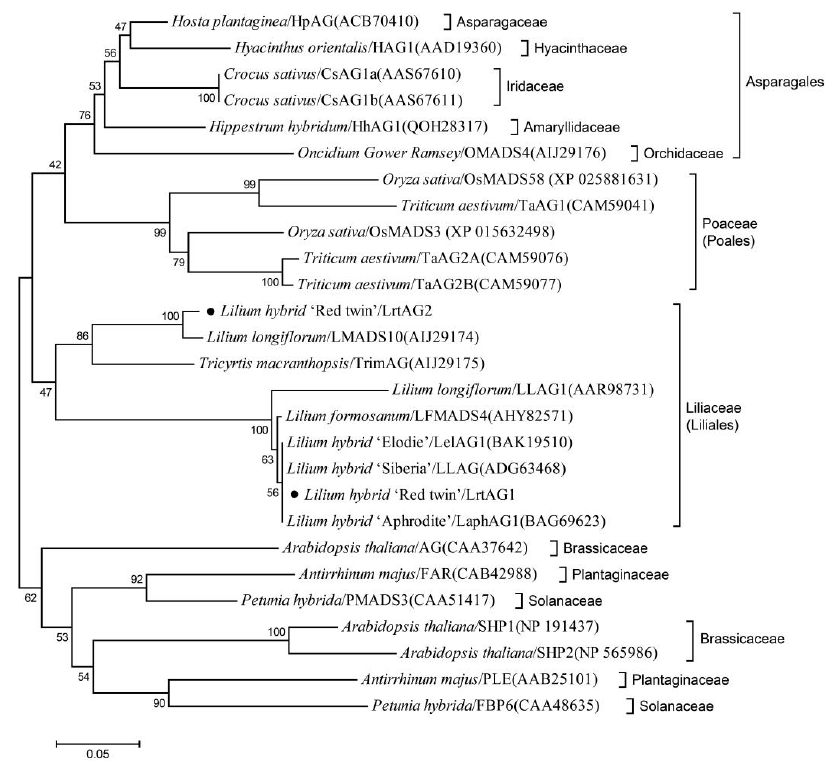
Figure 5. Phylogenetic relationship of LrtAG1 and LrtAG2 from Lilium hybrid ‘Red Twin’ and C-class gene proteins from 12 species. Node values indicate bootstrap support (%) from 1000 replicates. The prefixed black dots indicate LrtAG1 and LrtAG2. The numbers in brackets were the NCBI accession numbers of these